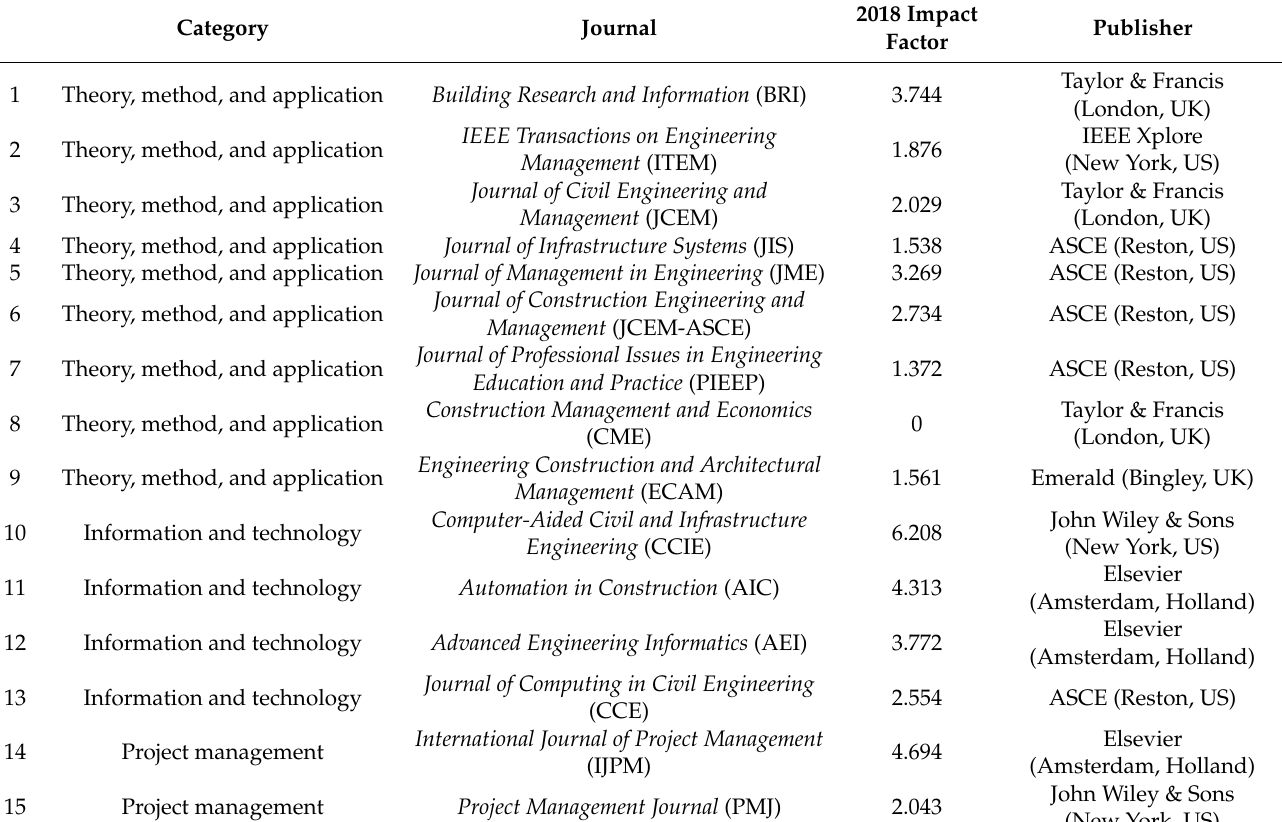
Table 1. Core journals of